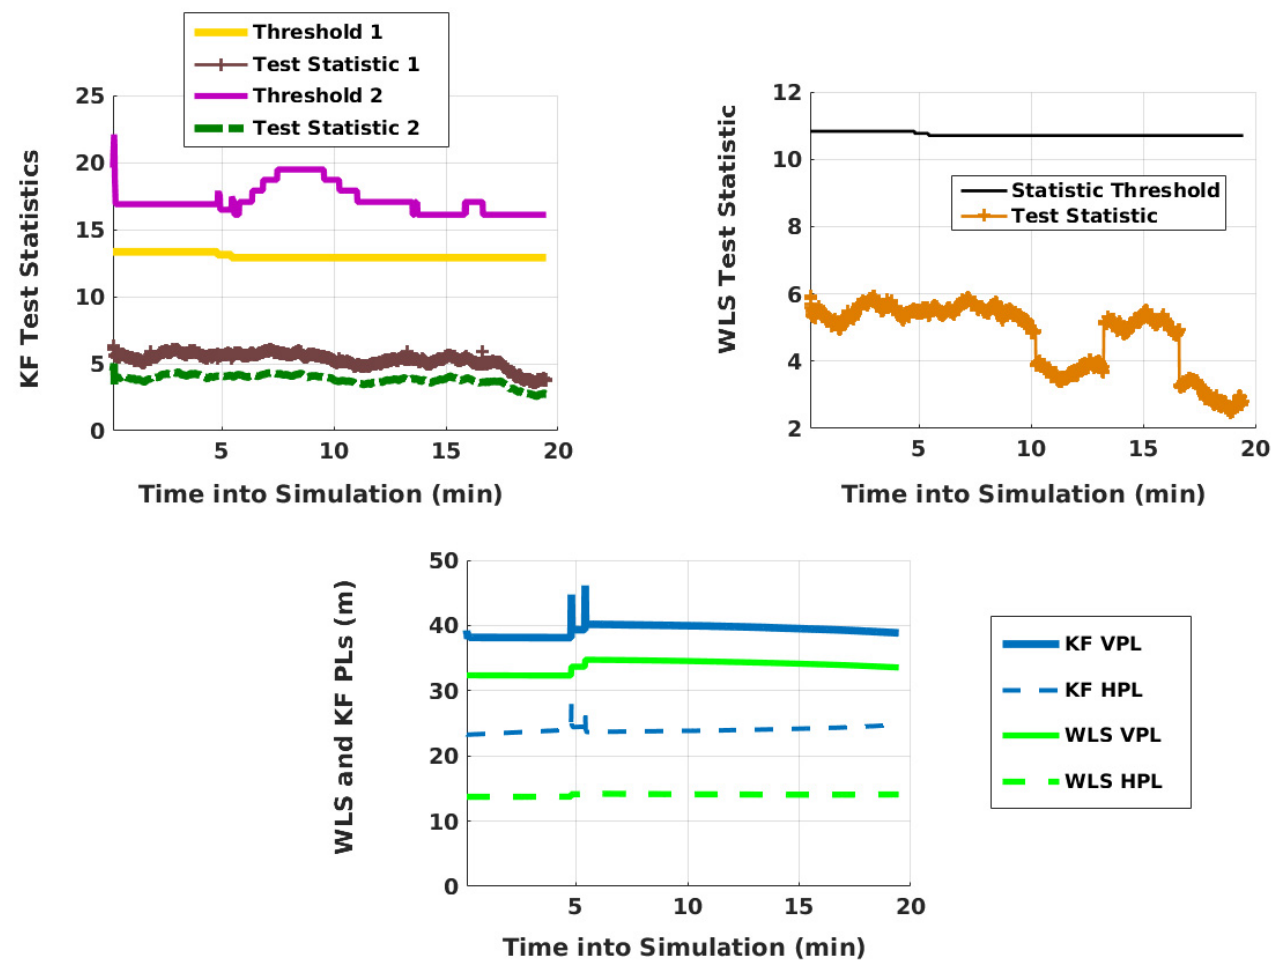
Figure 8. WLS and KF RAIM performance after an initial transient period of 15